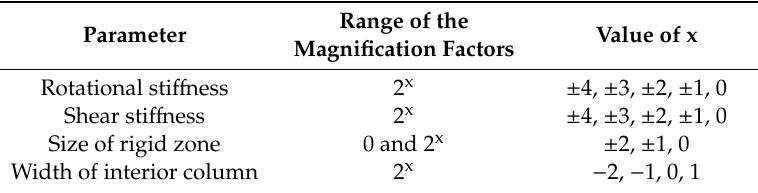
Table 7. Ranges of parameters.